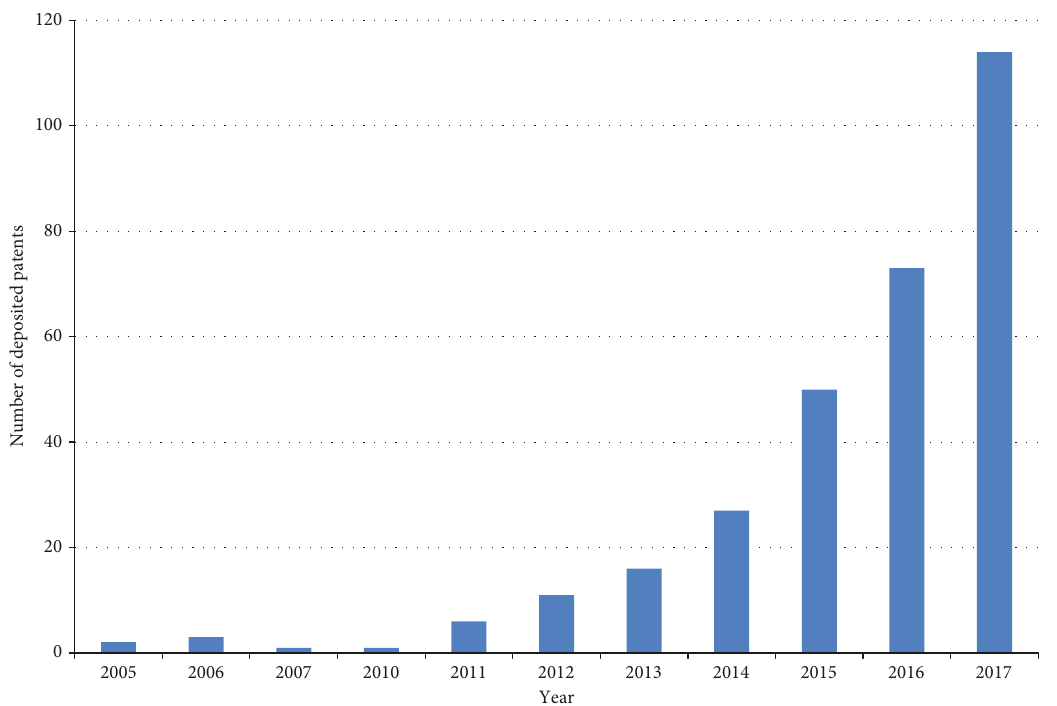
Figure 14: Number of deposited patents related to CubeSats between 2005 and 2017, totaling 304 patents (source: European Patent O ffi ce).